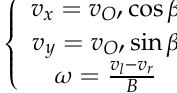
Figure 3. Kinematic model of the SIM.